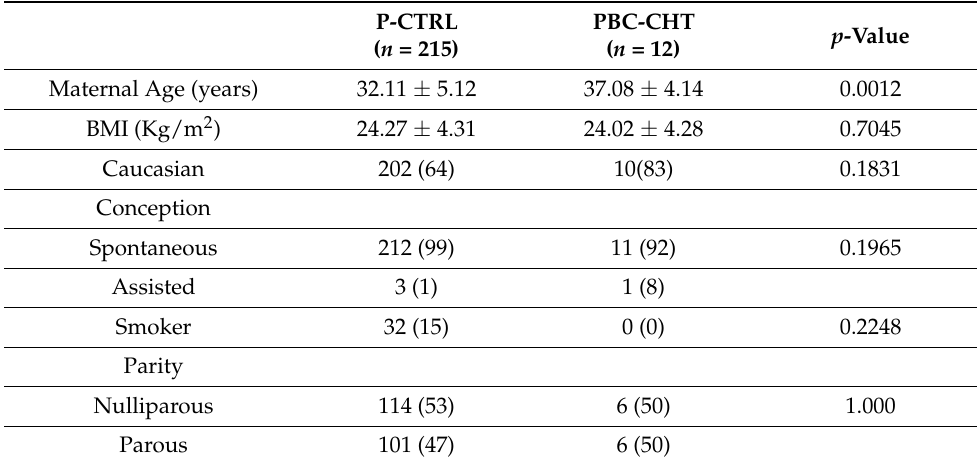
Table 1. Demographic characteristics of study